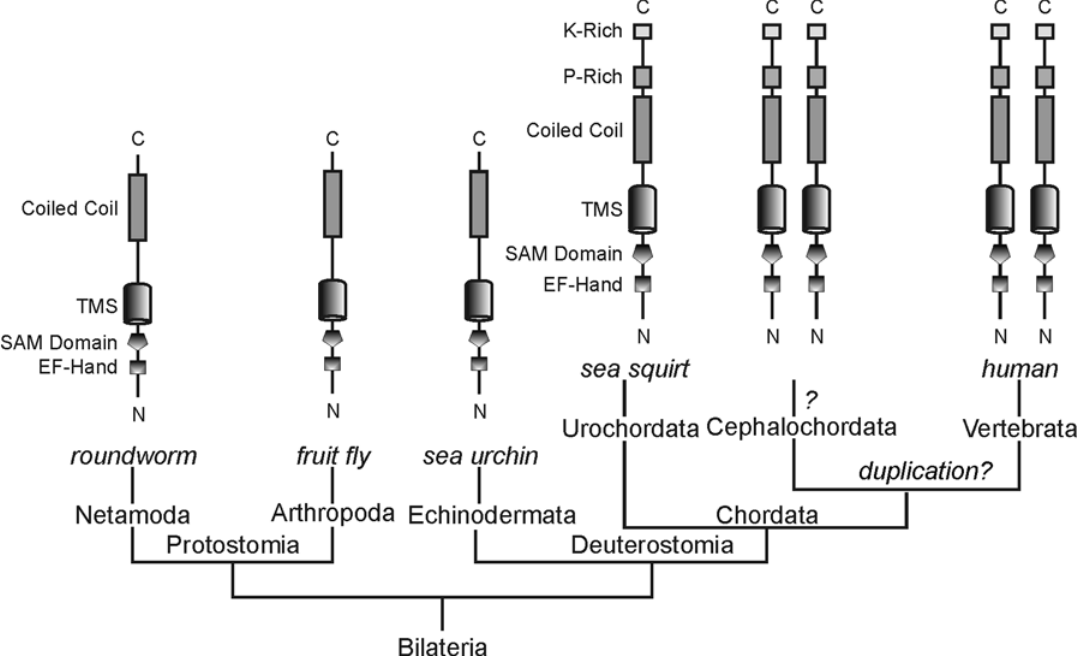
Figure 2. Evolution of the protein domains in the STIM protein family. Schematic representations of protein domains of representative STIM molecules based on phylogeny of bilaterian animals [51]. The proline-rich domain and the lysine-rich domain of STIM molecules, which are absent in worms, insects and sea urchin, first appeared in Urochordata, as shown in C. intestinalis . Duplication of STIM molecules speculated to have occurred after Cephalochordata/Urochordata divergence is indicated with ‘‘ ? ’’. Fish-specific duplication of STIMs (Fig. 1) is not illustrated here. C , C-terminus; K- rich , lysine-rich domain; N , N-terminus; P-rich , proline-rich domain; TMS , transmembrane segment.